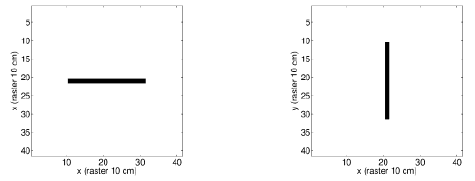
Figure 5. Horizontal and vertical line mask which is used for cross-correlation with the binary image.